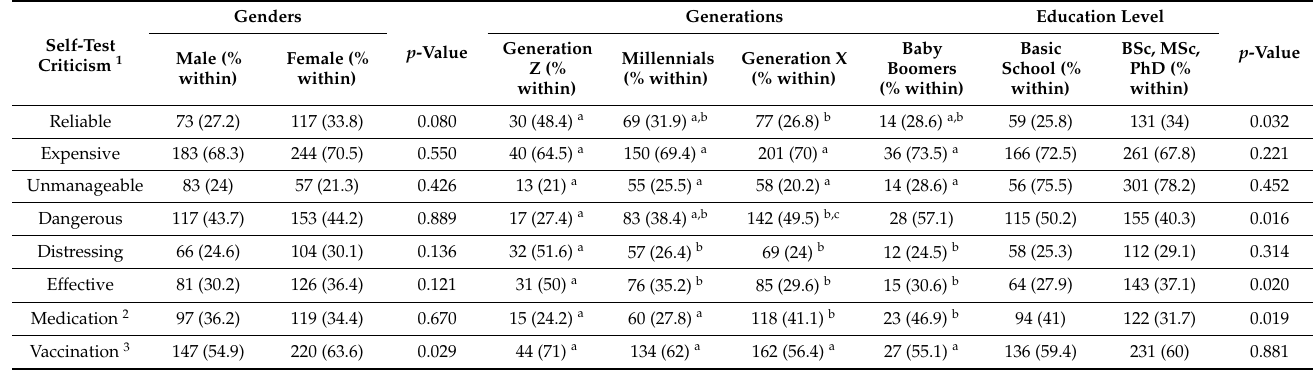
Table 2. Societal criticism for self-testing parameters and issues, n = 614.